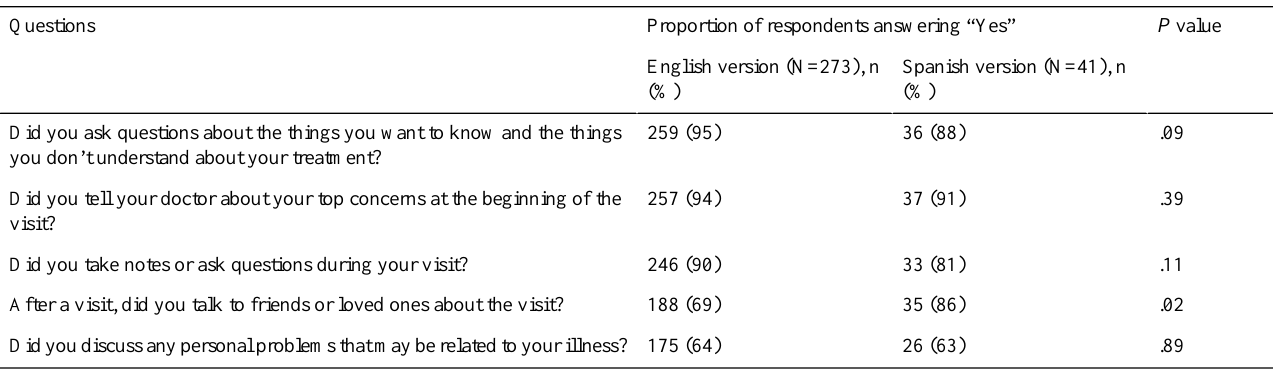
Table 1. Postvisit survey results comparing patients using the English version and those using the Spanish version of the Visit Planner Tool.